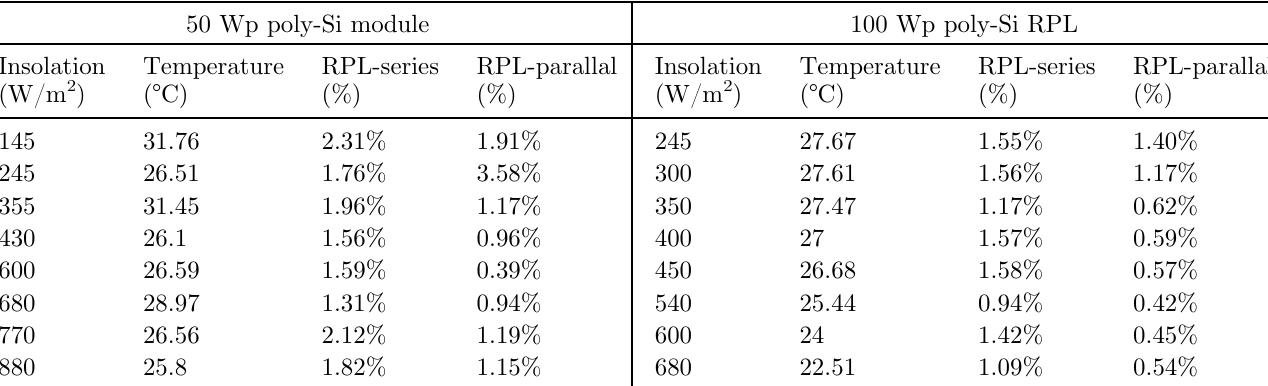
Table 4. RPL measurement for 50 Wp and 100 Wp poly-Si